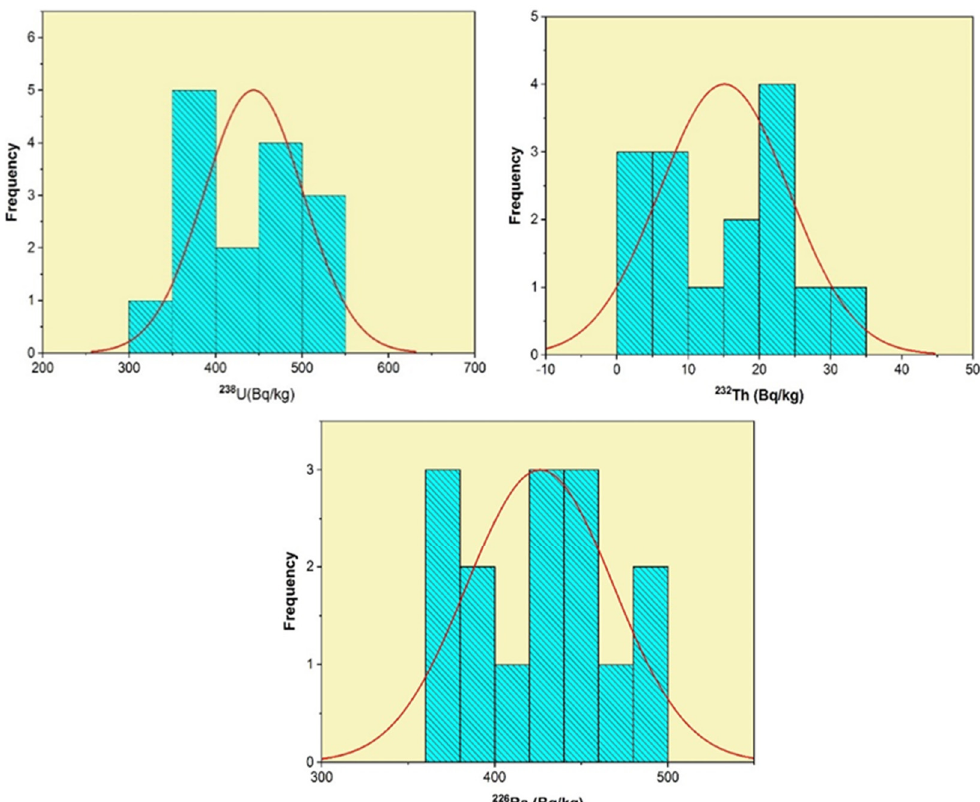
Figure 7. Frequency distribution histograms of 238 U, 232 Th, and 226 Ra activity concentrations, respec- tively.